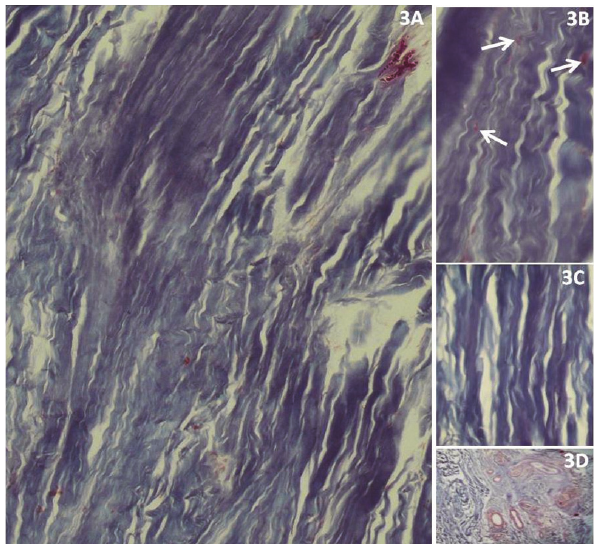
Figure 3: Histological sections of the ALL demonstrate dense colla- gen fibers (3A: Masson’s trichrome staining at magnification of 20x; 3C: Masson’s trichrome staining at magnification of 40x); fibroblasts (arrows in 3B: Masson’s trichrome staining at magnification of 40x); vascular tissue (3D: Masson’s trichrome staining at magnification of